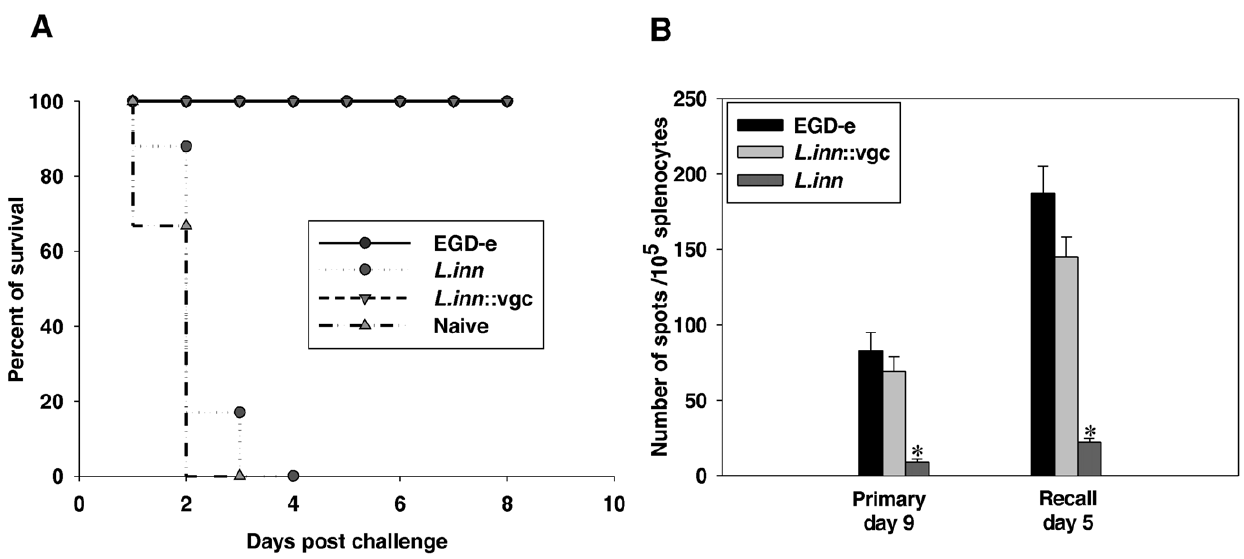
Figure 4. Protective immunity and cellular immune response after infection with Lm and the L.inn::vgc strain. A. Induction of protective immunity conferred after infection with the L.inn::vgc strain . Groups of 15 mice were infected i.v. as described in Fig. 1. Two months later all mice were challenged with a lethal dose (20 6 LD 50 ) of the wild type Lm . As a control, a group of uninfected normal mice was included. Survival of mice after the challenge was monitored up to 8 days. B. Number of antigen-specific IFN-gamma producing CD8 + T cells in spleens of mice infected i.v. with the wild type Lm , L.inn and L.inn::vgc strain determined by ELISPOT. Spleen cells from infected mice were isolated either on day 9 after the primary infection or day 5 after challenge infection and stimulated with the immunodominant MHC class I peptide LLO 91–99 in triplicates in nitrocellulose based 96-well culture plates. Number of specific IFN-gamma producing cells against the dominant H-2K d restricted LLO 91–99 epitope were determined by counting the number of spots under the microscope. *P , 0.05 ( L.inn vs. Lm and L.inn::vgc strains).